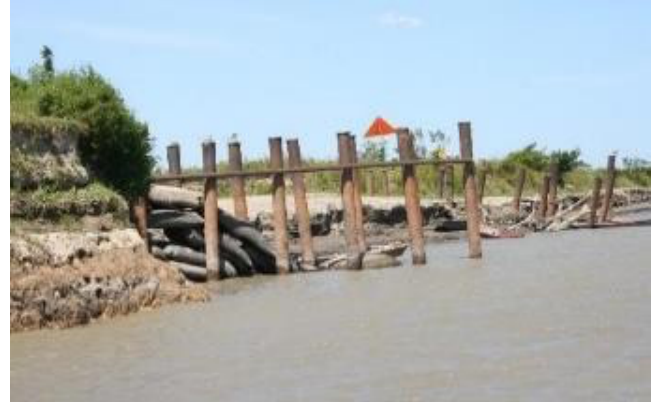
Figure 12. Rio Metica, Puerto López: ( a ) summary of the analysis of the evolution of the river among 1950, 2002, 2005, and 2007; ( b ) sector geometry and panel field design. Note the proximity of the river to the road in 2005 (Hidroconsulta, 2005 [13]; 2007 [12]).